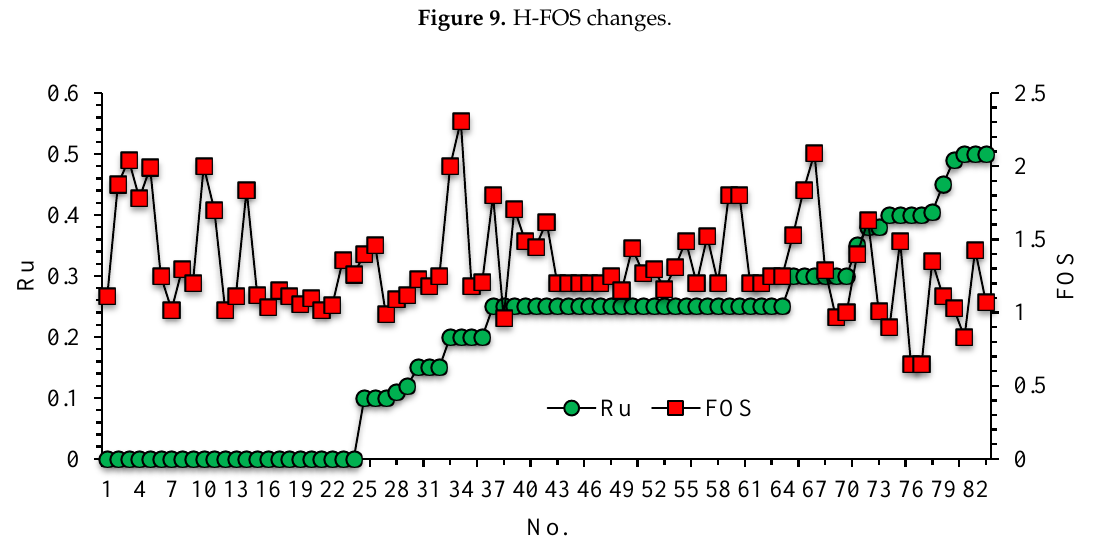
Figure 10. Ru-FOS Figure 10. Ru-FOS changes.